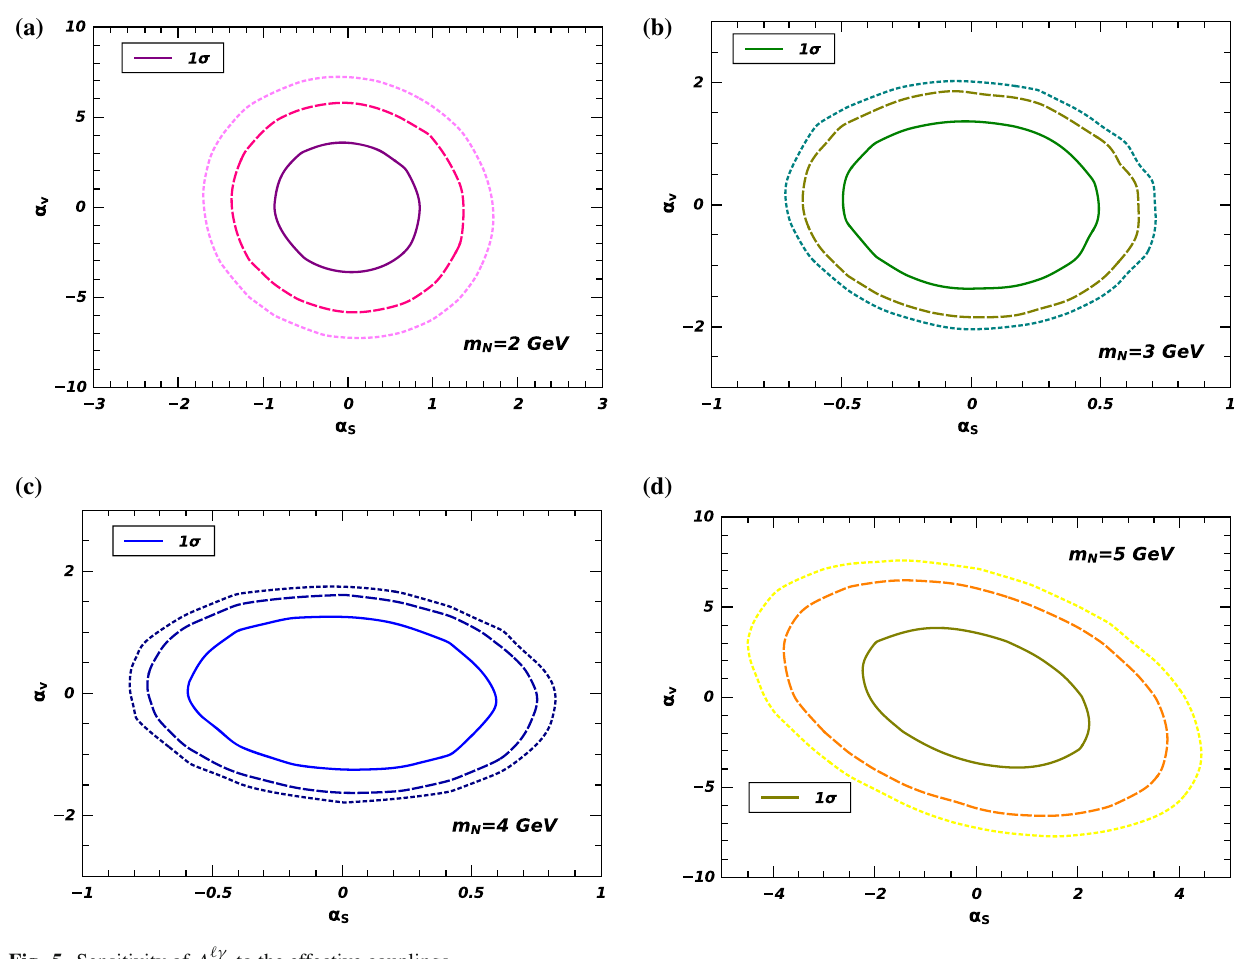
Fig. 5 Sensitivity of A